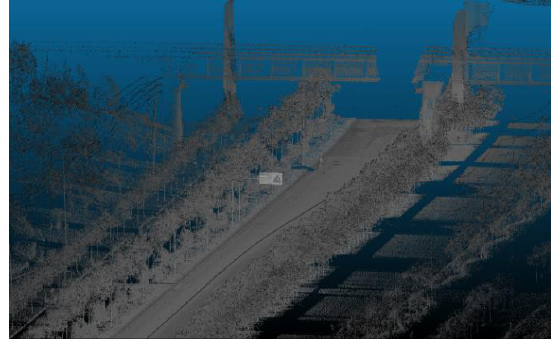
Figure 7. The point clouds from the Rigel LiDAR. The grayscale is based on the intensity of the laser.